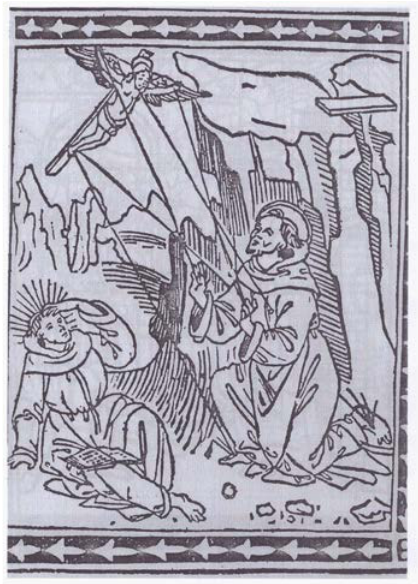
Figure 15 – La tauola de Fioretti di sancto Francesco , s.n.t. (from Kristeller 1897, n. 155a, 54, cut 27). Cornell University Library, Public Domain,